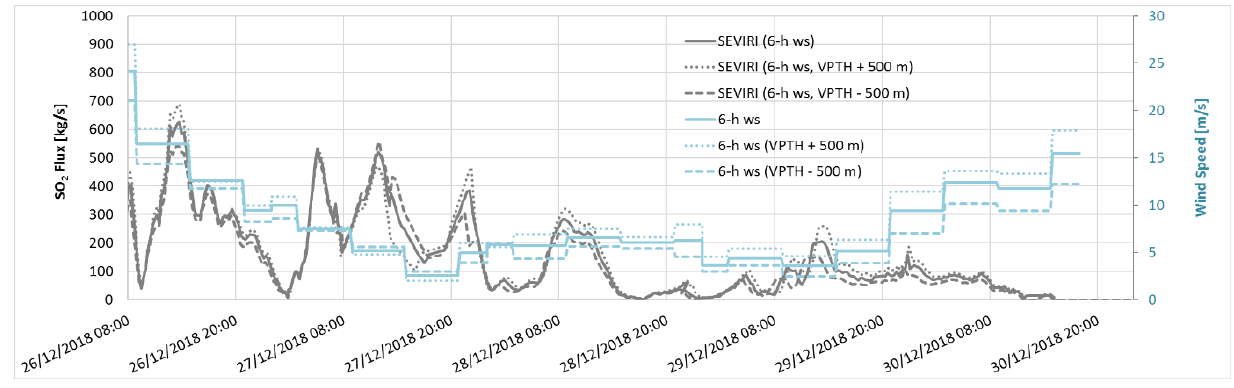
Figure 12. SEVIRI SO 2 fluxes computed considering different wind speeds obtained by considering an uncertainty of +/− 500 m of VPTH.